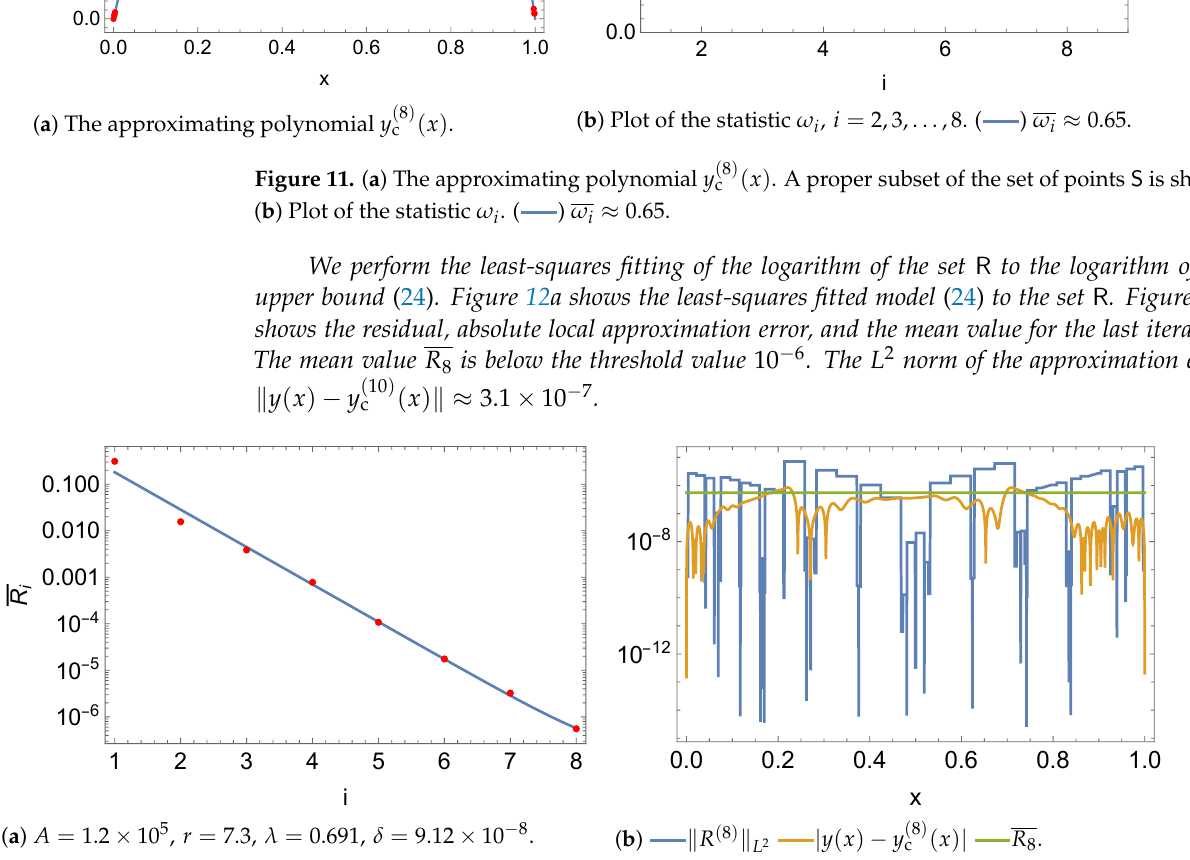
Figure 12. ( a ) Fitting the upper bound (24) with the set R . ( b ) Visualization of the residual, absolute local approximation error, and the mean